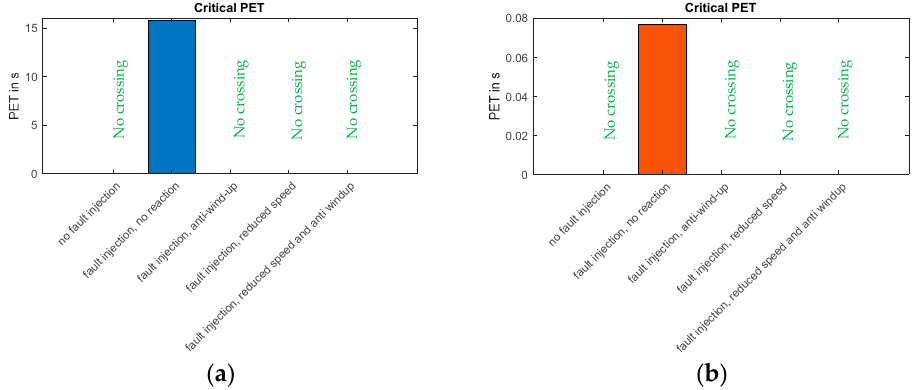
Figure 11. Mean ( a ) and minimal ( b ) values of the minimal PET values resulting from the parameter variation.